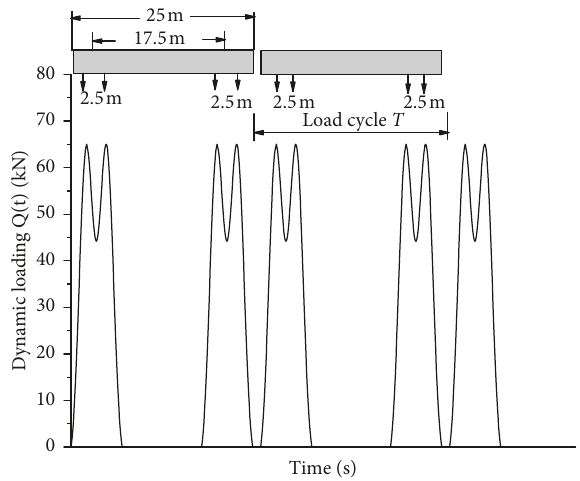
Figure 4: “M”-shaped wave.